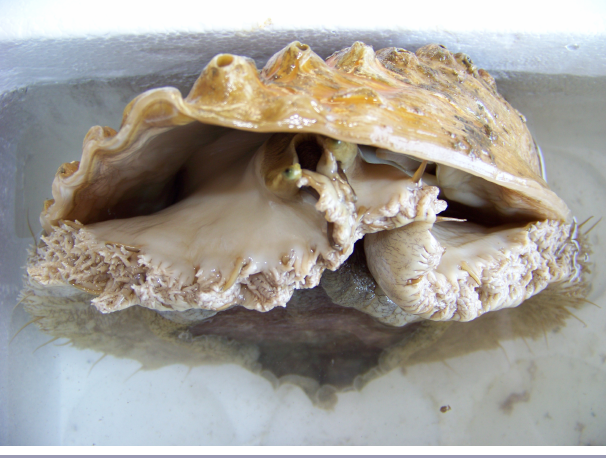
Fig. 6 . Abalone are a highly sought-after large edible sea snail. Photo credit: Molecular Breeding & Biodiversity Group, Department of Genetics, Stellenbosch